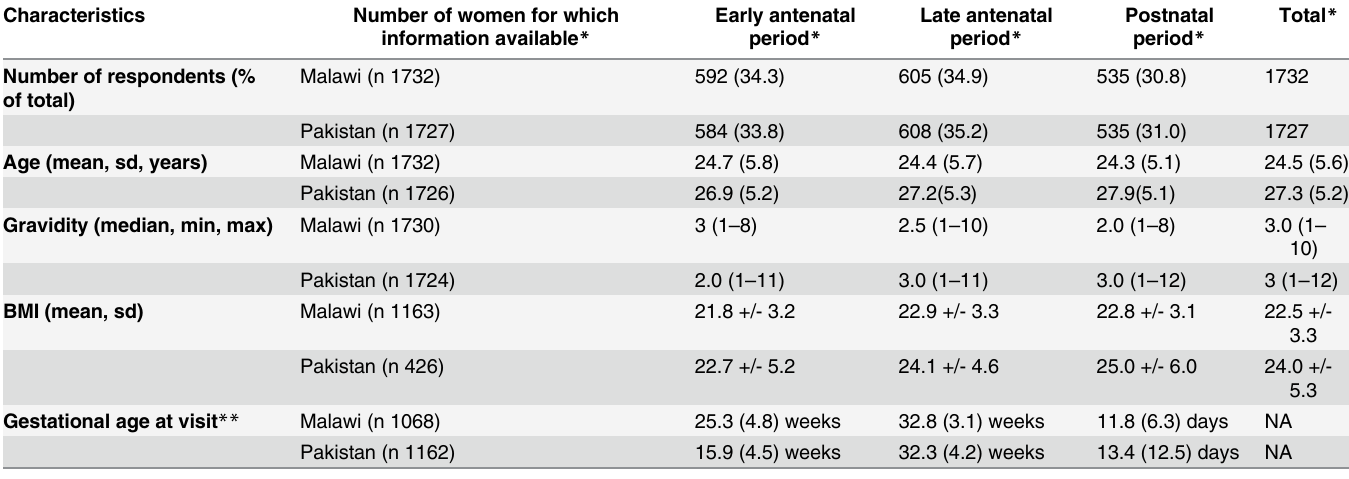
Table 1. Characteristics of study population.